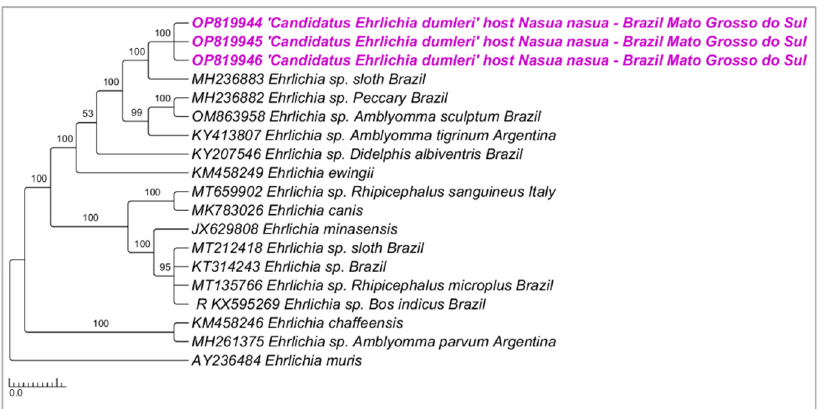
Figure 1. Phylogenetic tree inferred by the Bayesian method and based on the dsb gene from Ehrlichia spp. sequences obtained from blood from ring-tailed coatis ( Nasua nasua ) sampled in Campo Grande city, Mato Grosso do Sul state, Brazil. Sequences detected in the present study are highlighted in bold pink (VBA).